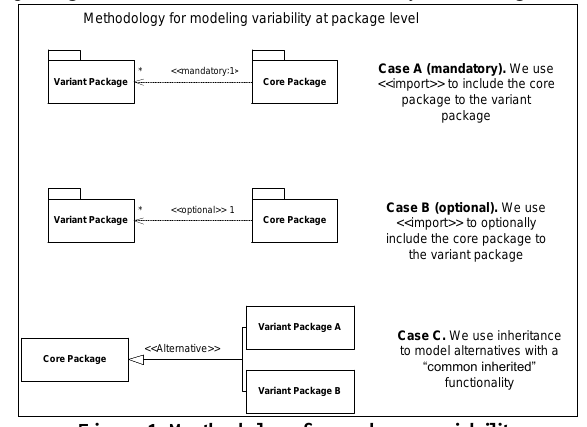
Figure 1. Methodology for package variability